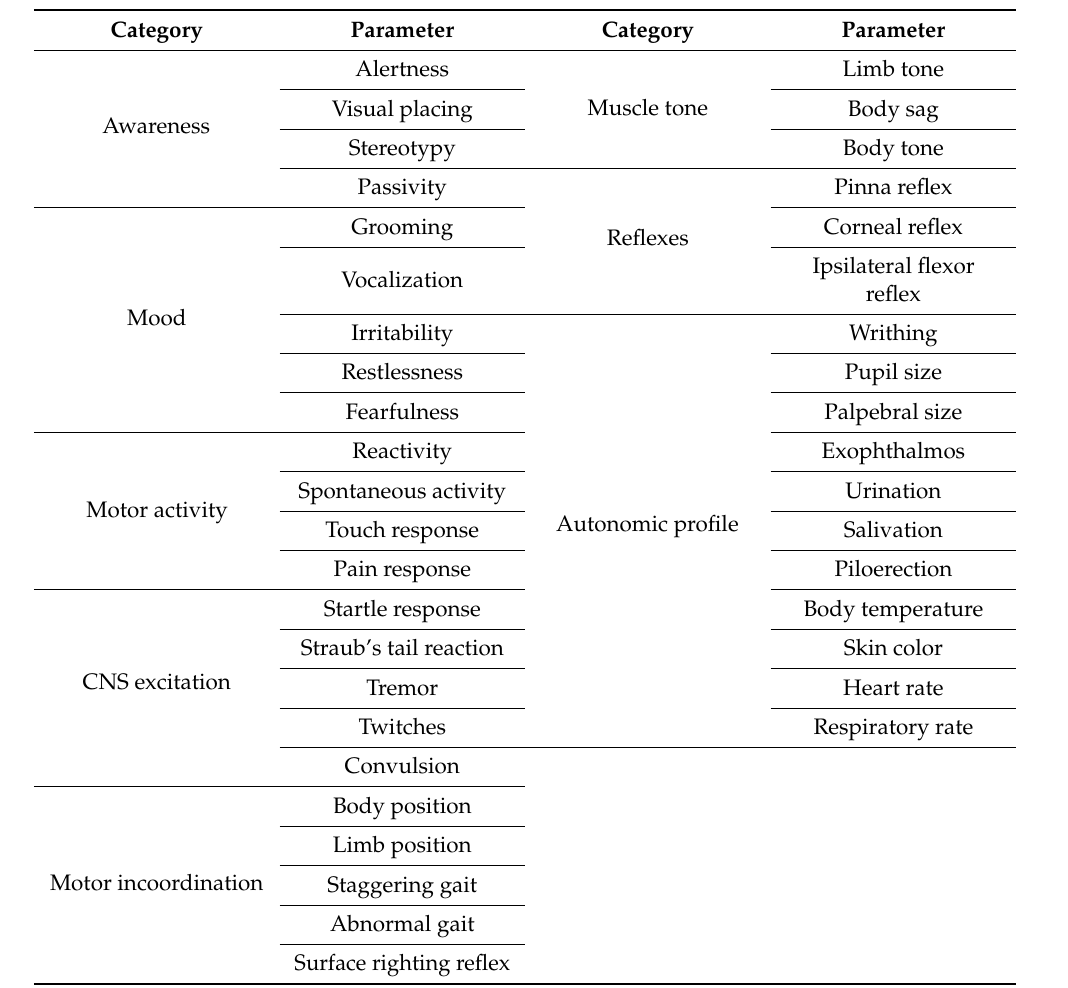
Table 2. Irwin’s Test: